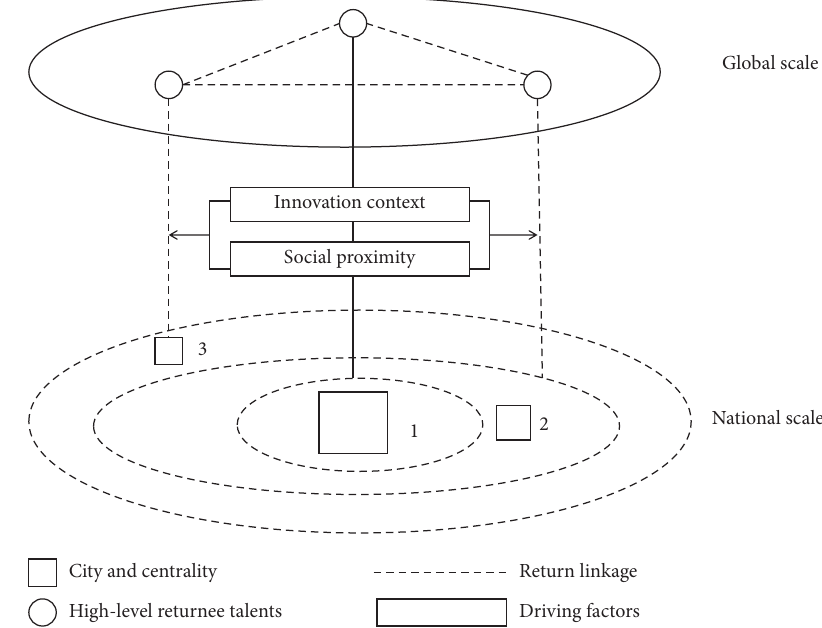
Figure 1: A typology of hierarchical cities driven by China overseas high-level returned